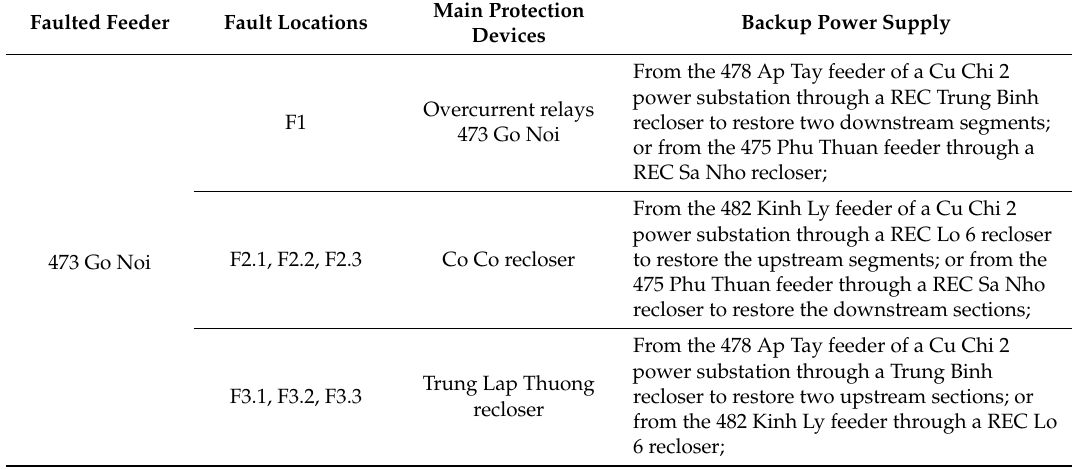
Table 10. Main protection devices and the back-up power supply in case of various fault scenarios.